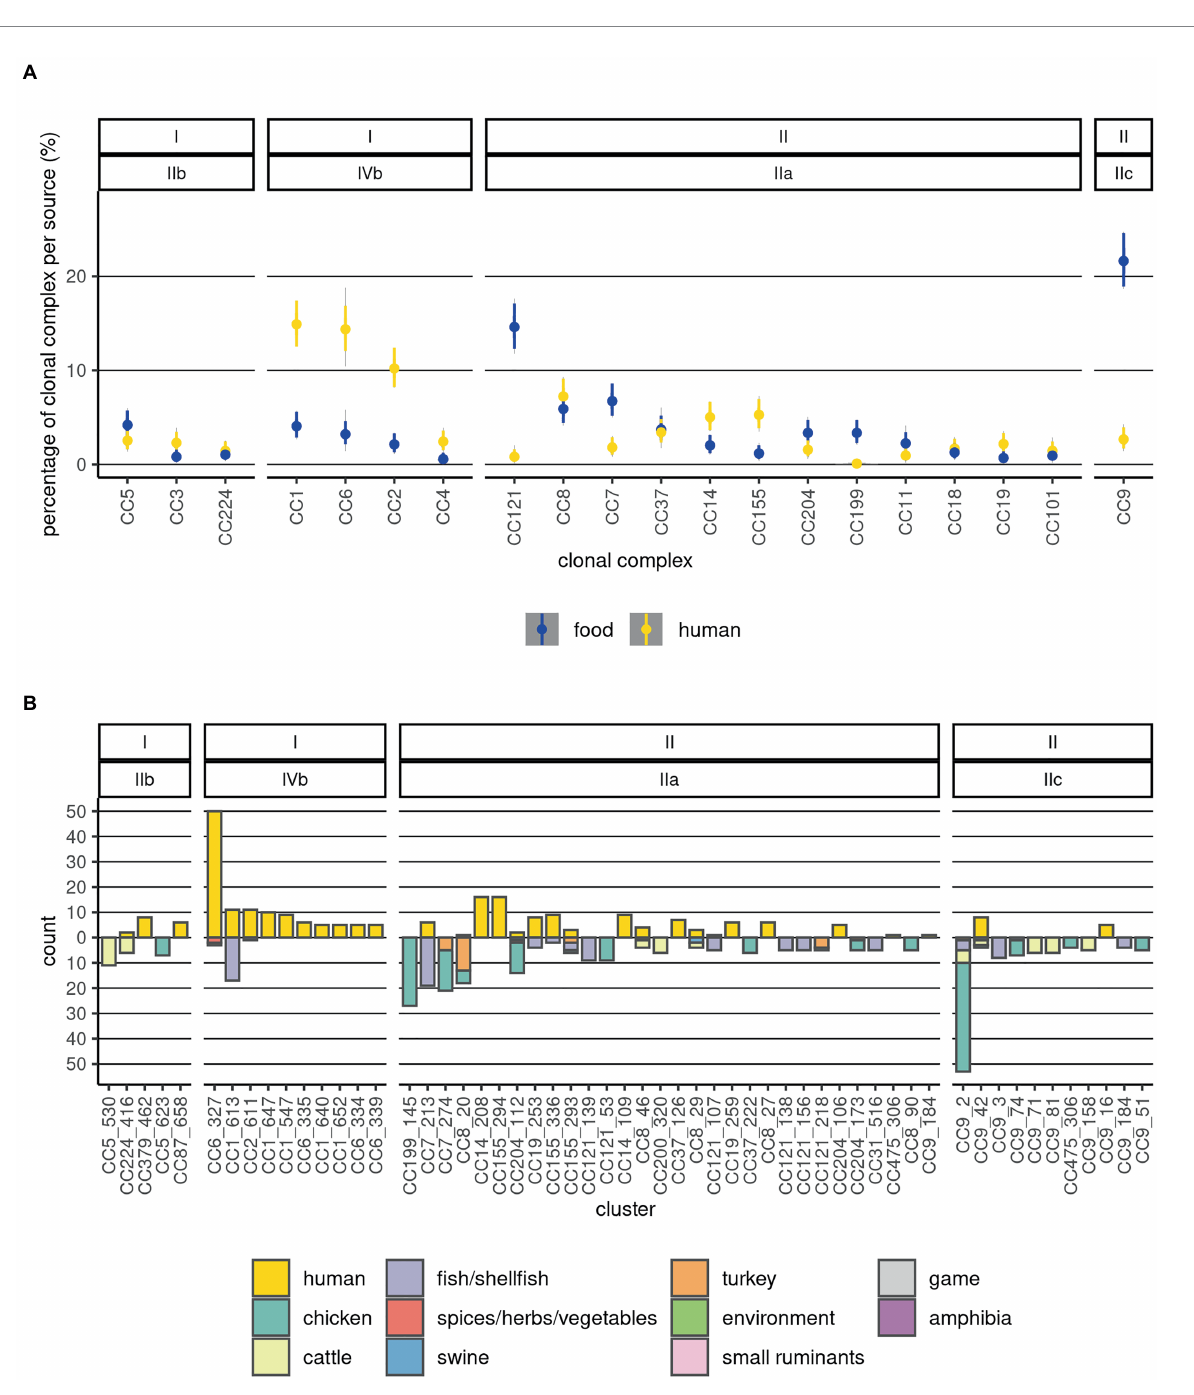
FIGURE 2 Distribution of sources and food product categories at CC and cluster levels. (A) The 20 most abundant CCs are depicted. Prevalences of CCs in the two sources are visualized as violin plots summarizing 10,000 draws of a Dirichlet distribution with probabilities equal to the observed ones; this was done in order to estimate the uncertainty associated with different and low sample sizes across the categories. (B) Distribution of the clusters by source and category of food products from which they were isolated. Counts of human Lm sequences are shown above the null of y-axis and those of food Lm sequences below it. The labels on top indicate the lineage and serogroup, and the x-axis labels indicate the CC and cluster. The sample type and food categories are depicted as fractions of the bars with distinct